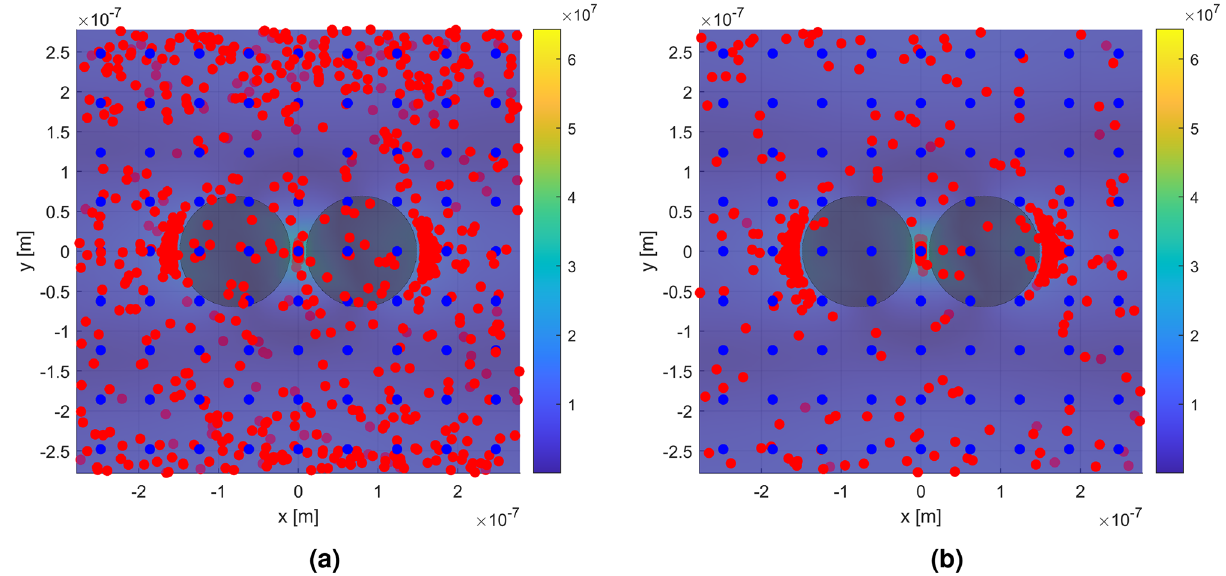
Figure 4. Top view of a single unit cell illustrating the trapping effect of the local field enhancement. The color scale indicates the electric field magnitude. The blue dots represent the initial particle positions in a regular array. The red dots represent the particle positions after ( a ) 1 ms, and ( b ) 10 ms, under influence of the external field. Dots with a slightly darker color indicates that they are behind the plane where the field magnitude is shown. The external field was produced by a plane wave incident from above with wavelength 785 nm and 2 power 50 mW μm − , polarized along the axis through the centers of both nanoantennas ( x -axis). The number of particles in initial positions appears lower due to their vertical alignment (along z ) in the array 19 . The distributions of particles distance from the hotspot are shown in the Supporting